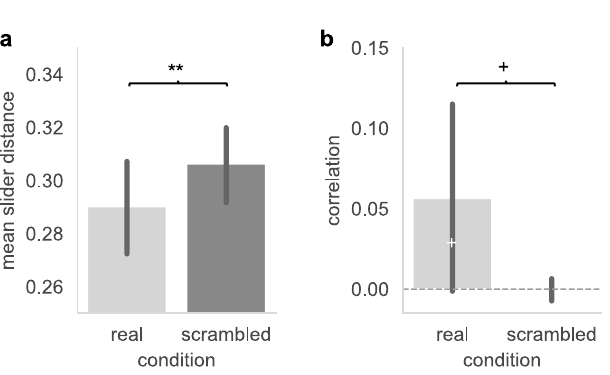
Figure 6. Coordination of directional intentions. ( A ) The degree of congruence between pairs of musicians’ directional intentions was measured as the average distance between slider values. Mean slider distance for real pairs highly significantly differed from mean slider distances computed over time-scrambled pairs (t(65) = 2.98, p = 0.004, d = 0.25), indicating that musicians’ directional intentions were closer to each other than would be predicted by chance. ( B ) Correlations (Pearson’s rho) only marginally differed from the chance-level computed from scrambled pairs (t(65) = 1.86, p = 0.067, d = 0.33) and from zero (t(65) = 1.85, p = 0.068, d = 0.23), with a small effect size reflecting the fact that some pairs tended to be correlated, and other pairs to be anti-correlated. Error bars show 95% confidence intervals, black asterisks show the pairwise t-test comparing real vs. scrambled data (with **p < 0.01; + p < 0.07) and white asterisks the one-sample t-tests comparing Pearson’s rho to zero (with + p <